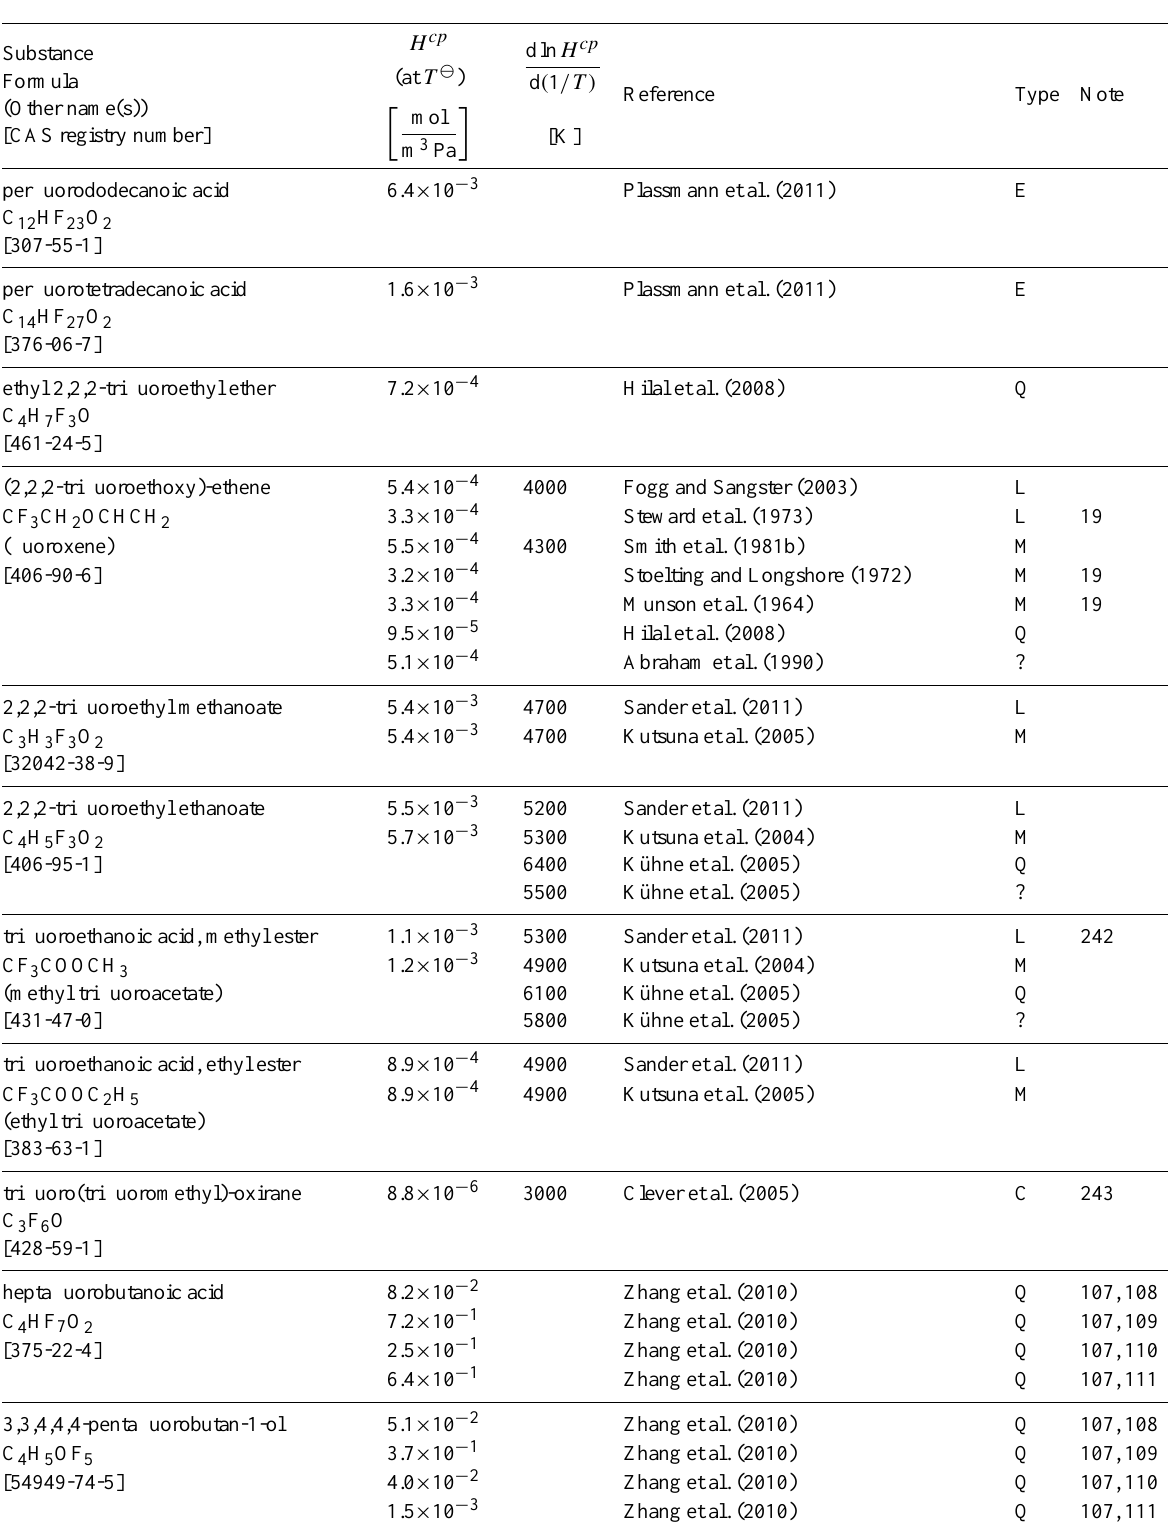
Table 6: Henry’s law constants for water as solvent